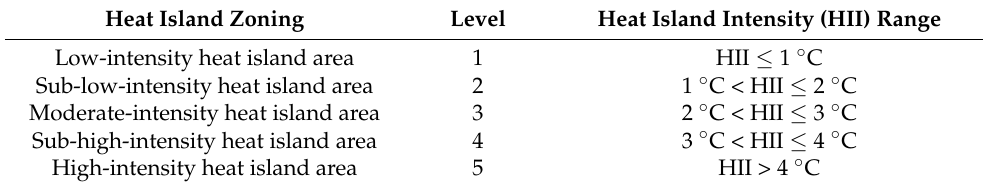
Table 5. ResNet-50 intensity level